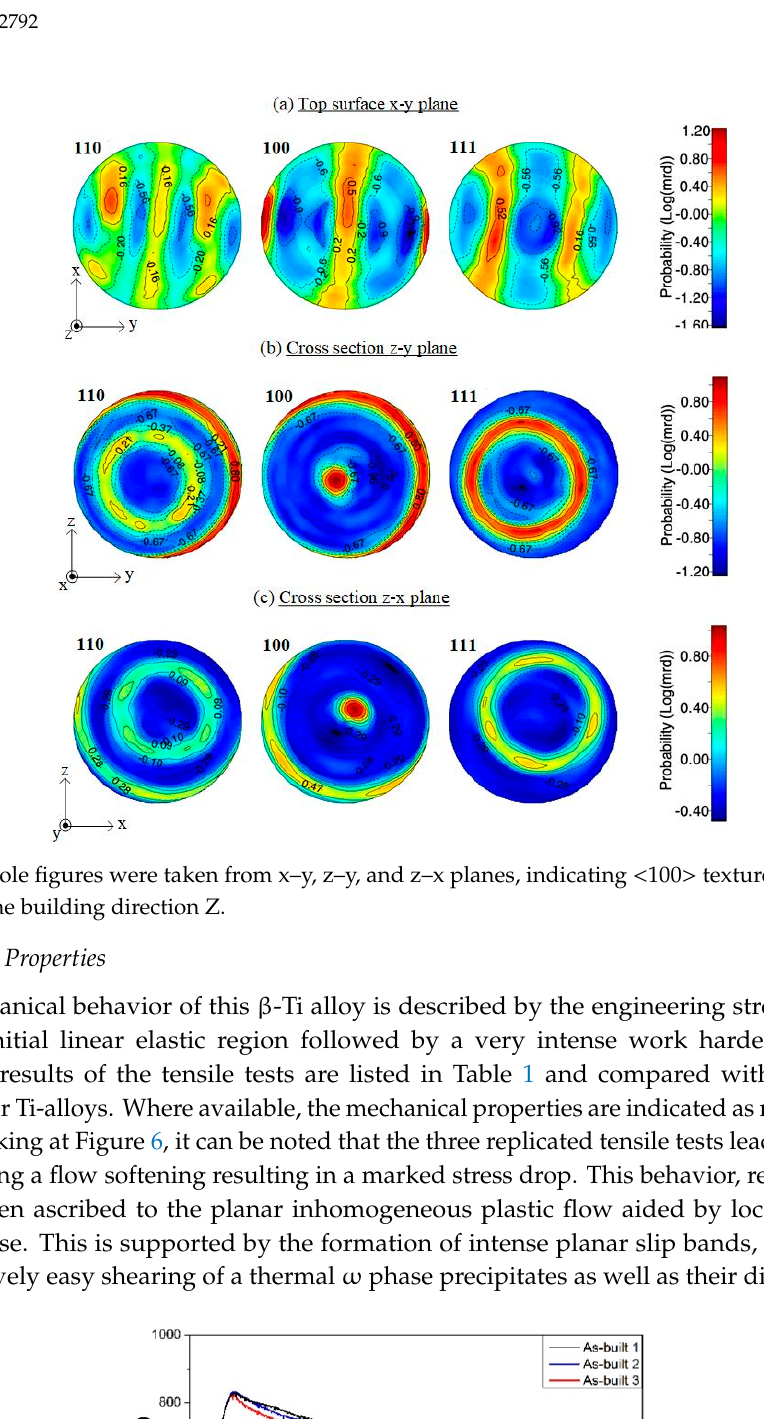
Figure 5. Pole figures were taken from x–y, z–y, and z–x planes, indicating <100> texture in parallels planes to the building direction Z.